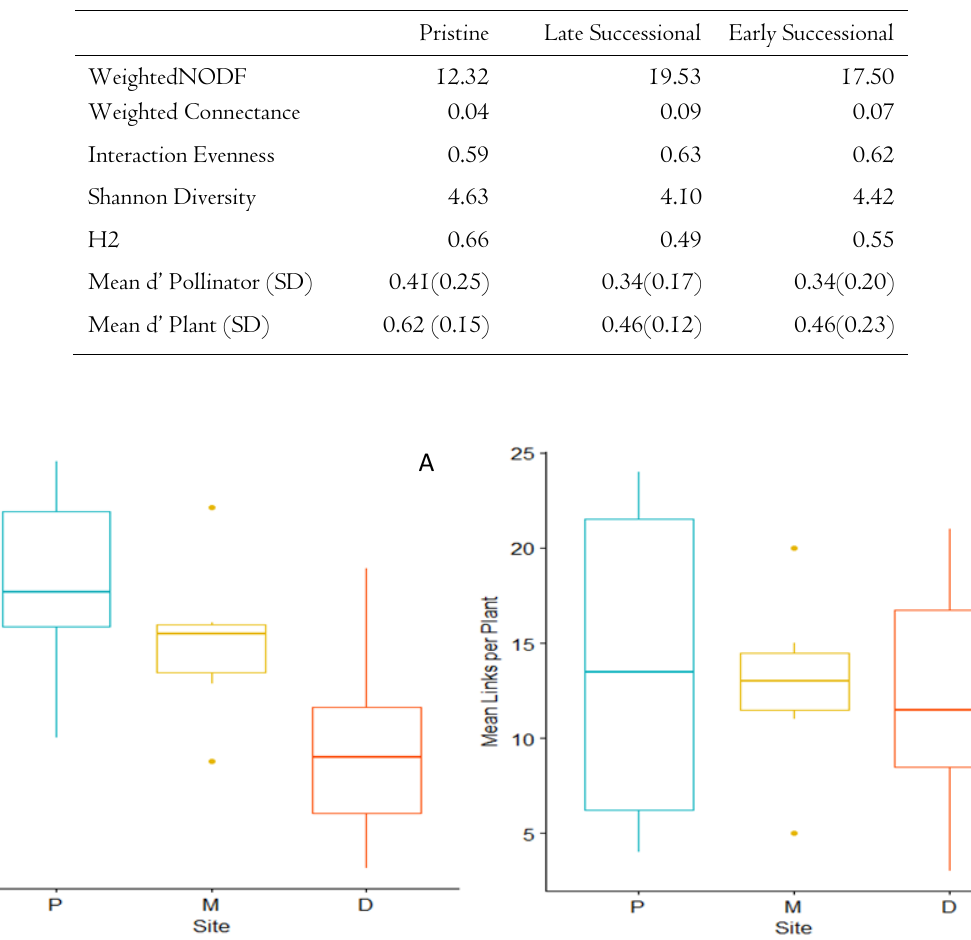
F IGURE 4: Box plots for (A) species- level specialization values (d’), and ( B) mean links per plant for the six plant species found in all three sites. P=Pristine; M=Late Successional; D=Early Successional. P and D are significantly different at P<0.05 in (A).